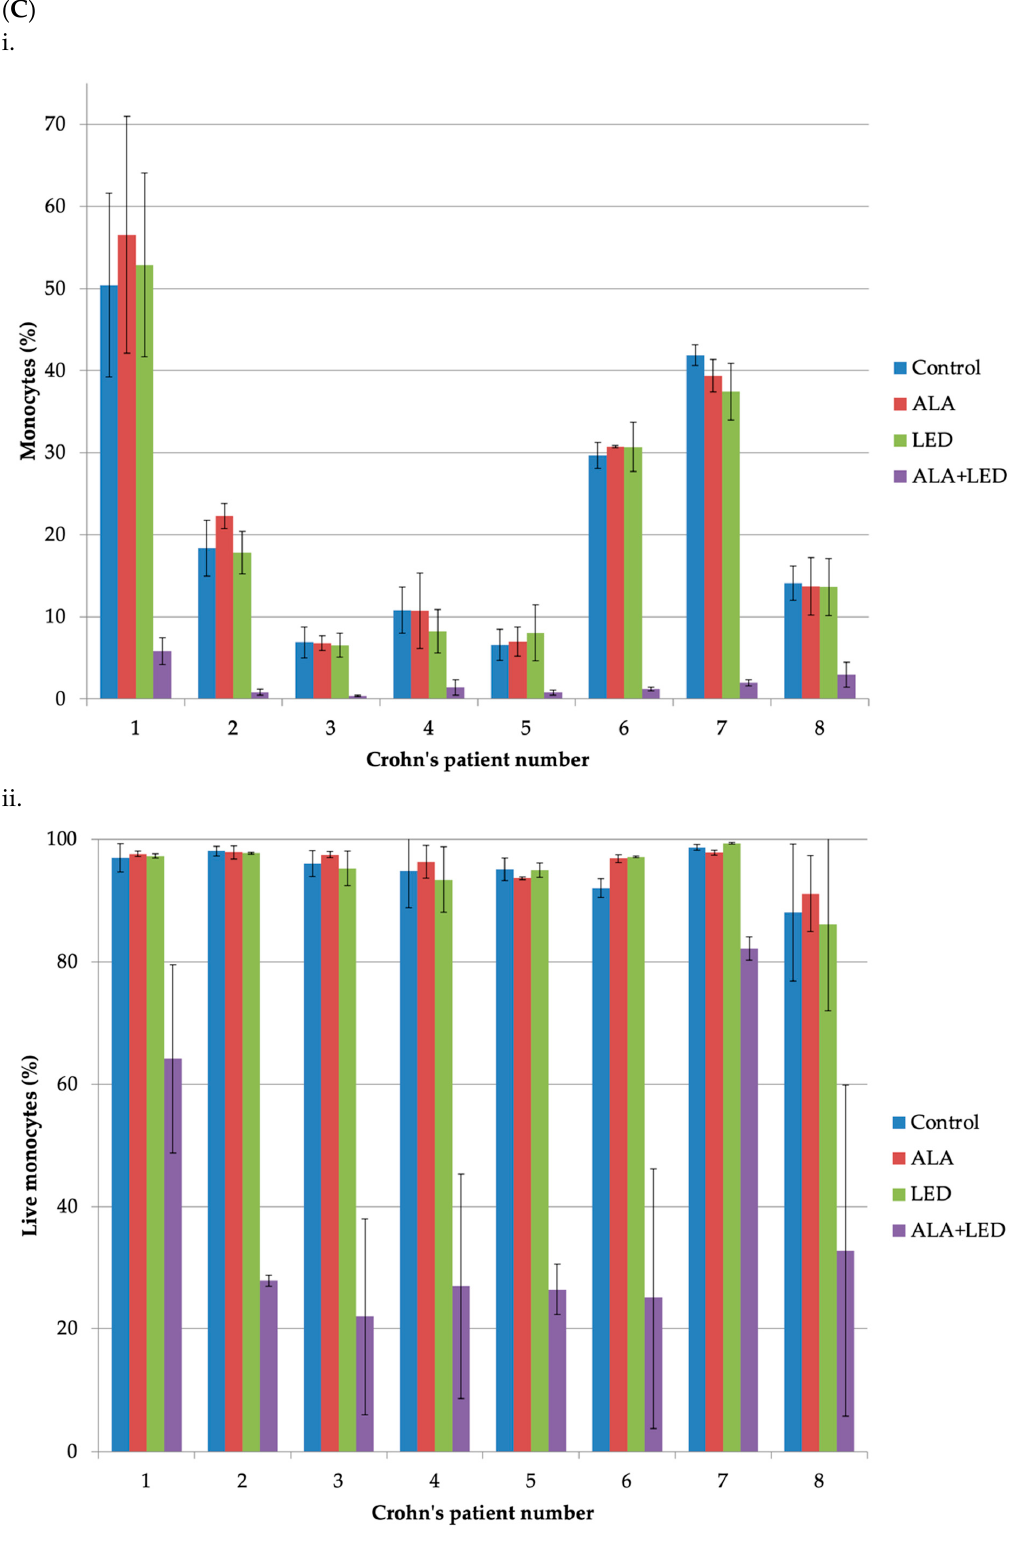
Figure 2. Cell survivals of PBMC subsets of CD patients after ALA-PDT in vitro. ( A ) Lymphocytes; (i) percentages of lymphocytes of PBMCs, (ii) fractions of live lymphocytes in respective patient samples in (i); ( B ) B-cells; (i) percentages of B-cells of PBMCs, (ii) fractions of live B-cells in respective patient samples in (i); and ( C ) monocytes; (i) percentages of monocytes of PBMCs, (ii) fractions of live monocytes in respective patient samples in (i). The ALA-PDT protocol is described in Section